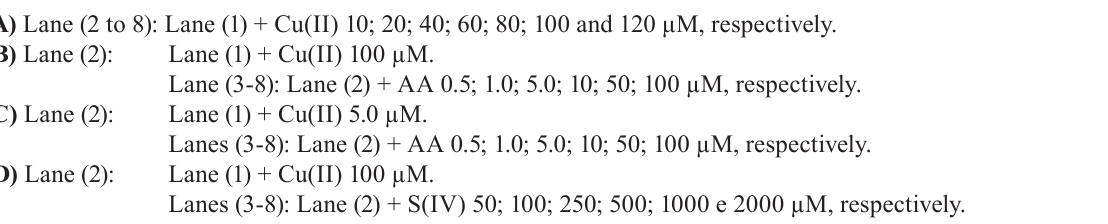
FIGURE 1 – Gel electrophoresis of pUC-19 DNA in the presence of Cu(II) and AA. Saturated air solution ([O = 5.5; T = (21 ± 2) ºC. All lanes (1) contain only pUC-19 DNA= 5.0 ng μL -1 .